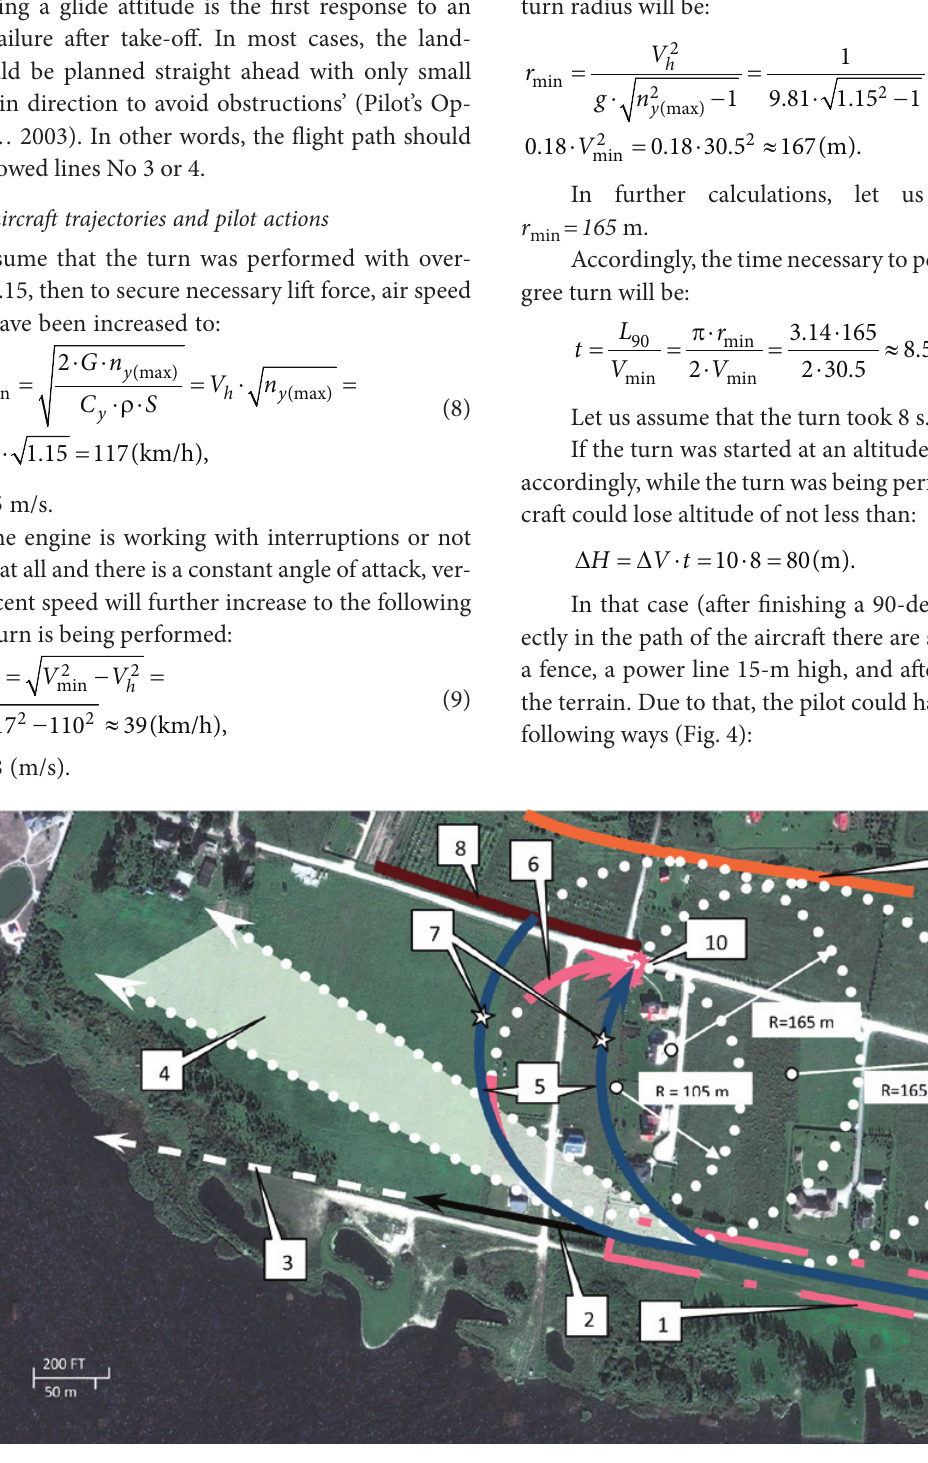
Fig. 4. Satellite photo of the Cessna 152 crash site, with an explanation scheme for calculation option No 2: 1) take-off runway; 2) take-off heading; 3) direction of aircraft if engine had shut down in flight and no additional manoeuvering had taken place (as per FM); 4) allowable range of maneuvering if engine had shut down in flight (as per FM) and attempts were made to avoid obstacles; 5) the possible range of trajectories for the plane; 6) one of the most abrupt aircraft flight paths; 7) point at which aircraft has made a turn of 90 degrees from original heading; 8) electrical power lines and fence; 9) onset of a rise in the terrain; 10) the location of the